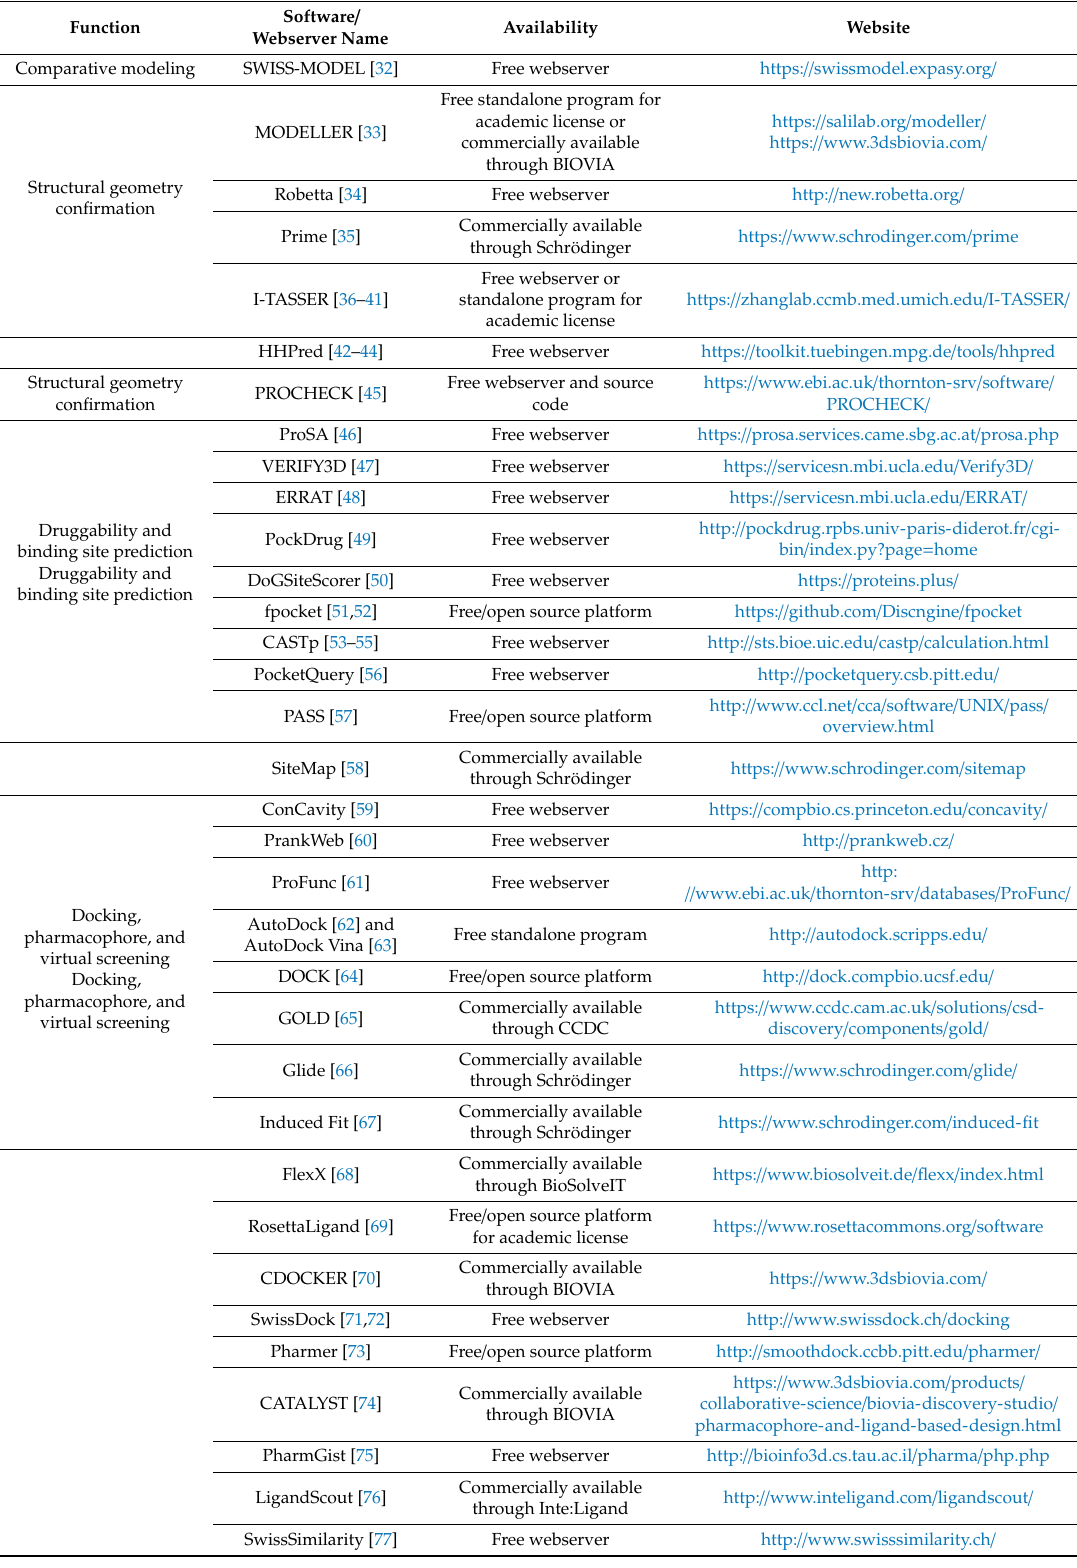
Table 1. Free and commercially available programs, webservers, and source codes for SBDD and LBDD.